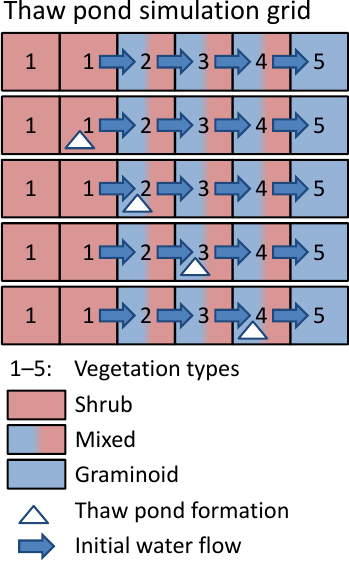
Figure 3. Simulation grid used to simulate thaw pond initiation in the vegetation types 1–4. Water flows at the start of the simulation are as indicated in the diagram. After the local permafrost collapse, the water flow from the cell with the thaw pond formation to the fol- lowing downslope cell is stopped (see Fig. 8 for the